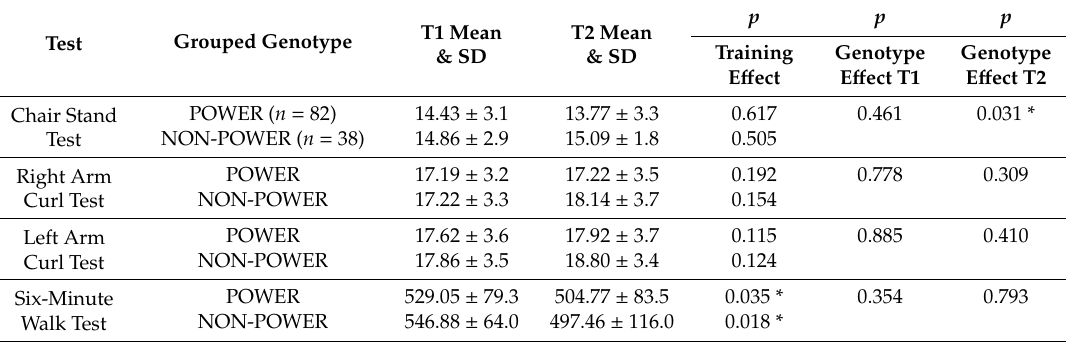
Table 3. E ff ect of training and combination of ACTN3 and ACE genotype on physical